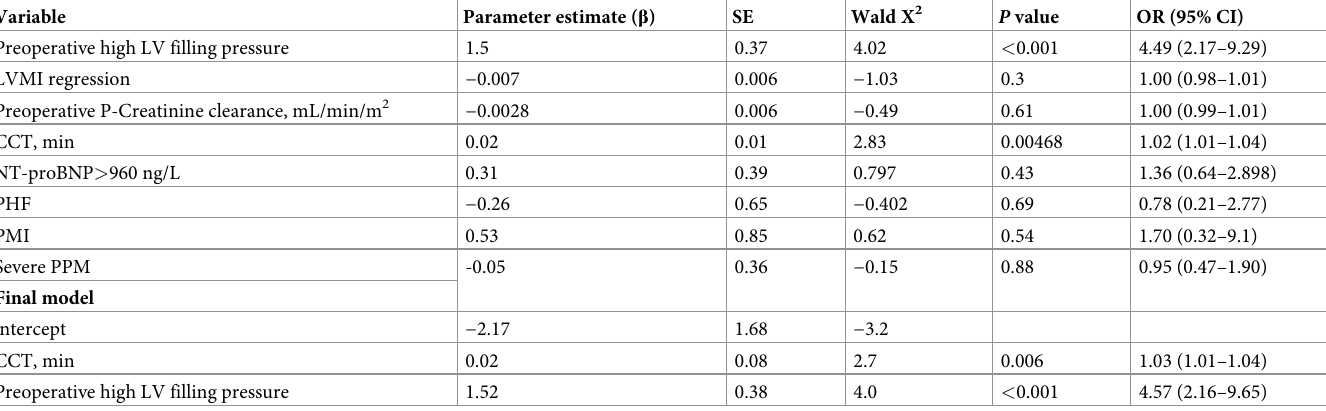
Table 5. Logistic regression, univariable and multivariable analyses of postoperative high LV filling pressure. Variable